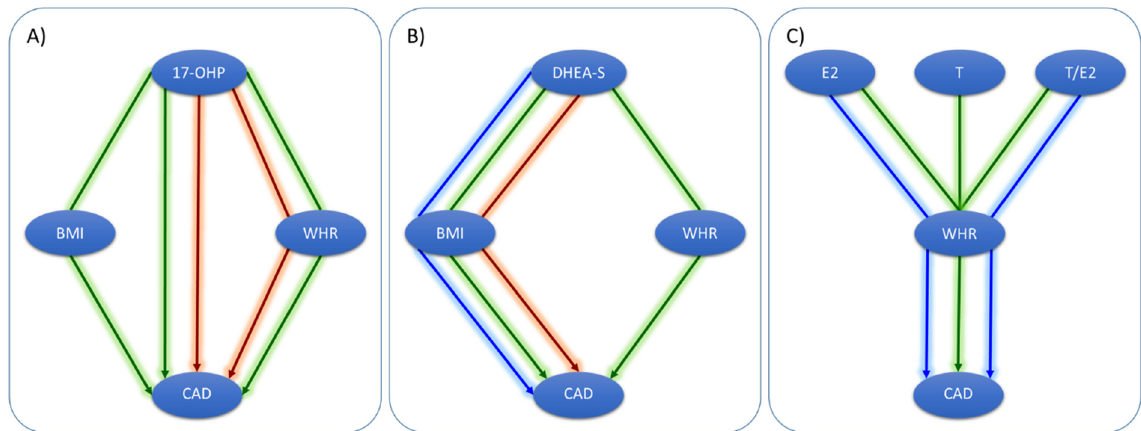
Figure 5. Detected causal networks of direct and indirect effects. Arrows indicate the analysis setting: green = combined; blue = males; red = females. ( A ) For 17-OHP, we detected direct and indirect effects on CAD, mediated by both BMI and WHR. ( B ) For DHEAS, we detected only indirect effects on CAD, mediated by both BMI and WHR. ( C ) For E2, T, and T/E2, we found indirect effects on CAD via WHR.